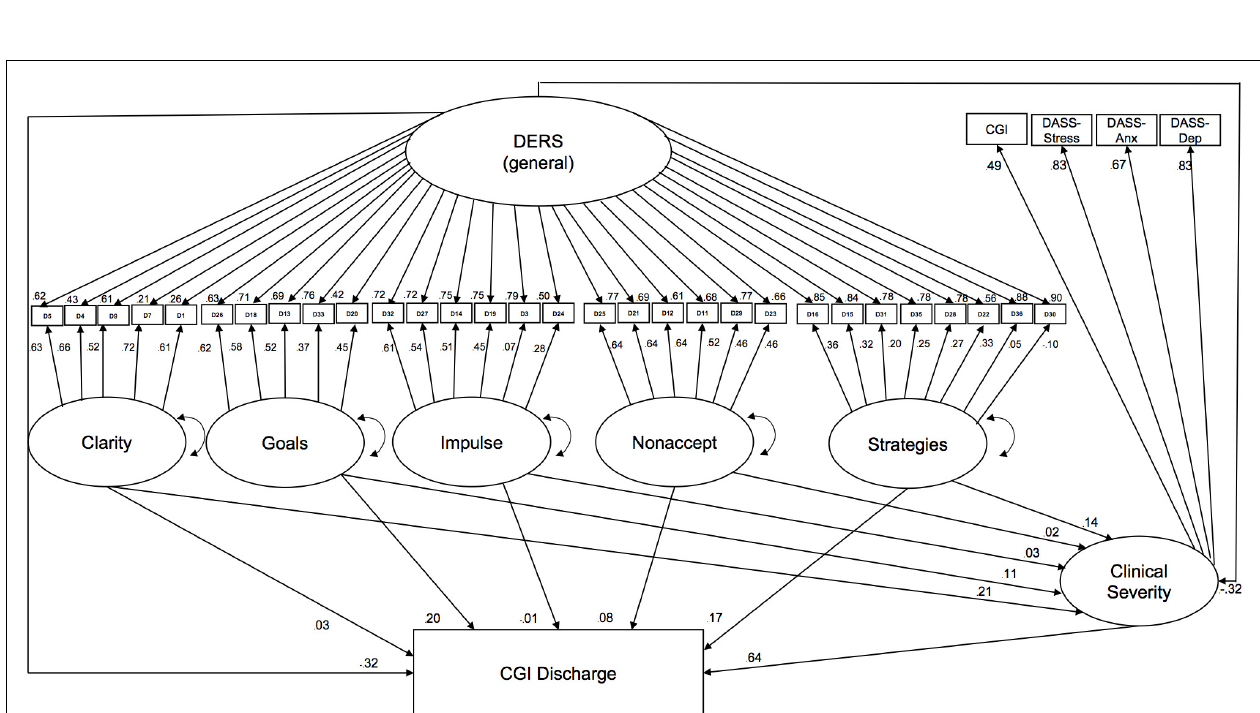
FIGURE 2 | Contributions of the DERS general and specific factors to predicting clinical severity.